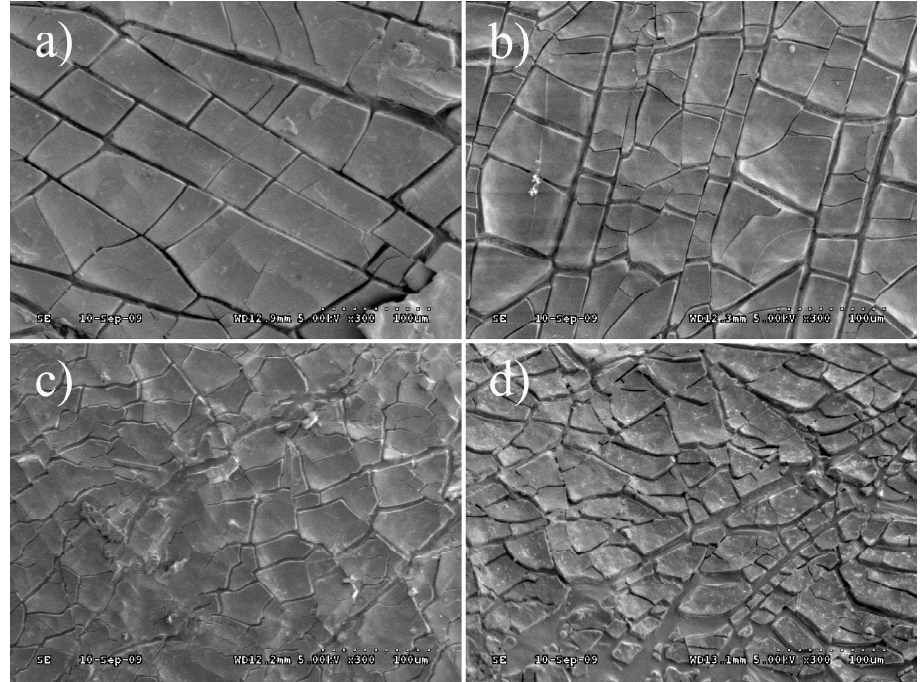
Figure 9. Apparent morphology of SBS modified bitumen after UV aging in different environments: ( a ) UV; ( b ) UV + Water; ( c ) UV + Acid; and, ( d ) UV + Salt.